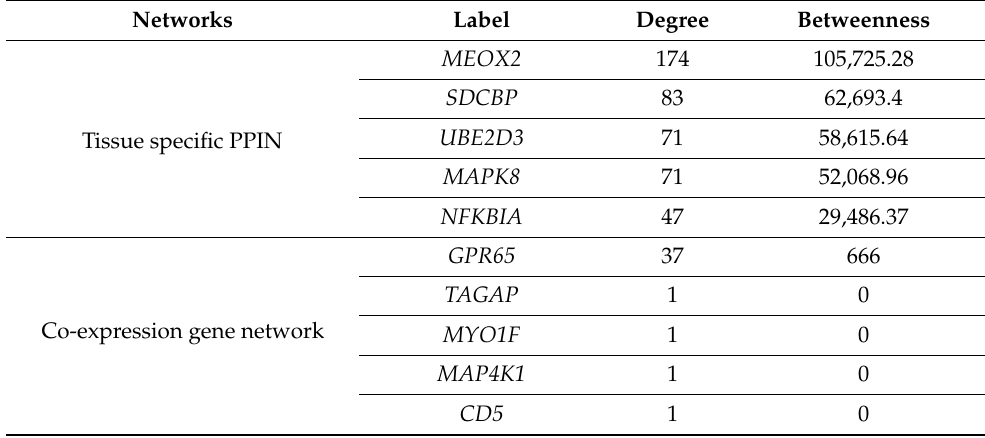
Figure 2. Co-expression gene regulatory network related to miR-499 functional modules. GPR65 is the seed node (illustrated in green). Peripheral red nodes indicate co-expressed nodes (the statistical network details are outlined in Supplementary File S1). miR, microRNA; GPR65, G protein-coupled receptor 65. Table 3. Top-ranked hub nodes of constructed